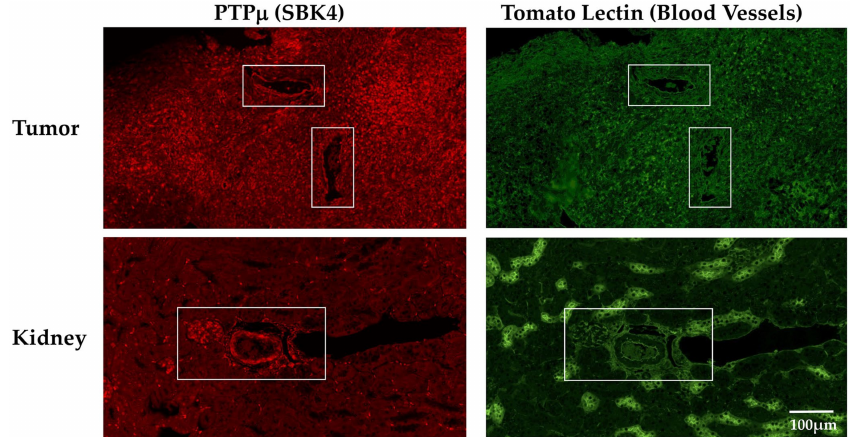
Figure 5. Localization of the PTP µ biomarker and endothelial cells in tumor and kidneys. Tumors and kidneys were obtained from mice bearing LN-229 flank tumors, fixed and stained with SBK4-TR, a peptide agent specific for the PTP µ biomarker and fluorescein isothiocyanate (FITC)-labeled tomato lectin. The top left panel shows high levels of the PTP µ -biomarker throughout the tumor, as well as on the surface of vascular structures (boxed areas). Diffuse tomato lectin staining (top right panel) was found throughout the tumor as well as on the same vascular surfaces (boxed areas) as the PTP µ biomarker. Less of the PTP µ biomarker was detected overall in the kidney (lower left panel), compared to tumor, but the vasculature showed high levels of the biomarker (boxed area). Tomato lectin stained vascular structures, similar to the bright SBK4-TR areas, as well as distinct cells throughout the kidney. All images were acquired at the same scale shown in the lower right